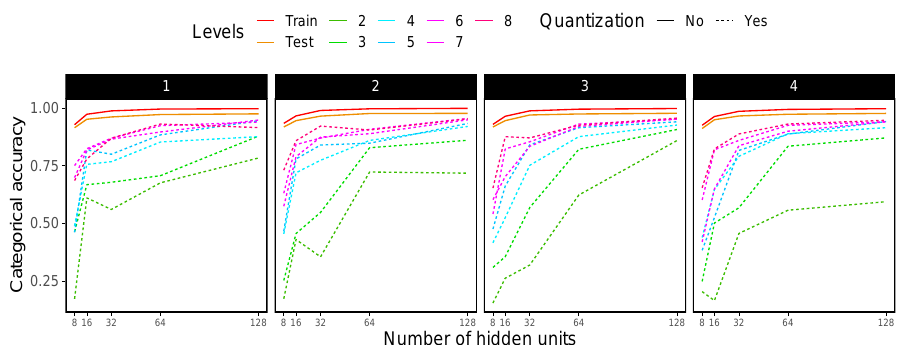
Figure 8. Categorical accuracy for the MNIST dataset. Experiments using 1 to 4 hidden layers, shown in each of the boxes, were used. For each hidden layer, hidden units ranging from 8 to 128 were tested ( x axis). Each dashed line in the plots shows the accuracy for different quantization levels, while solid lines indicate no quantization.